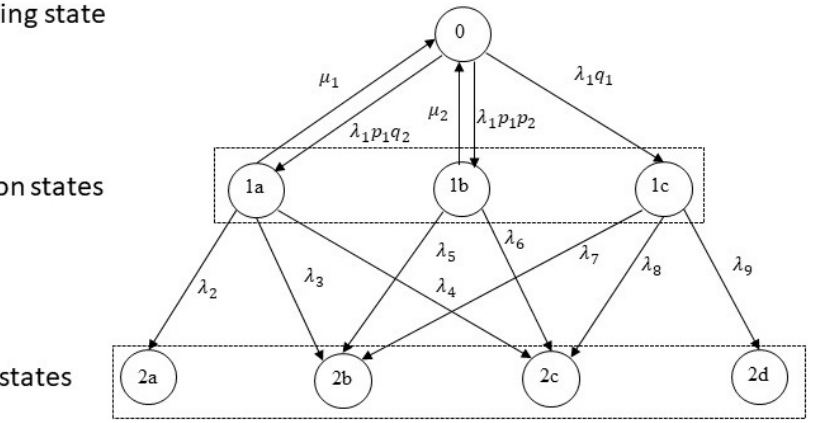
Figure 1. State transition diagram of hardware-software interaction failures.